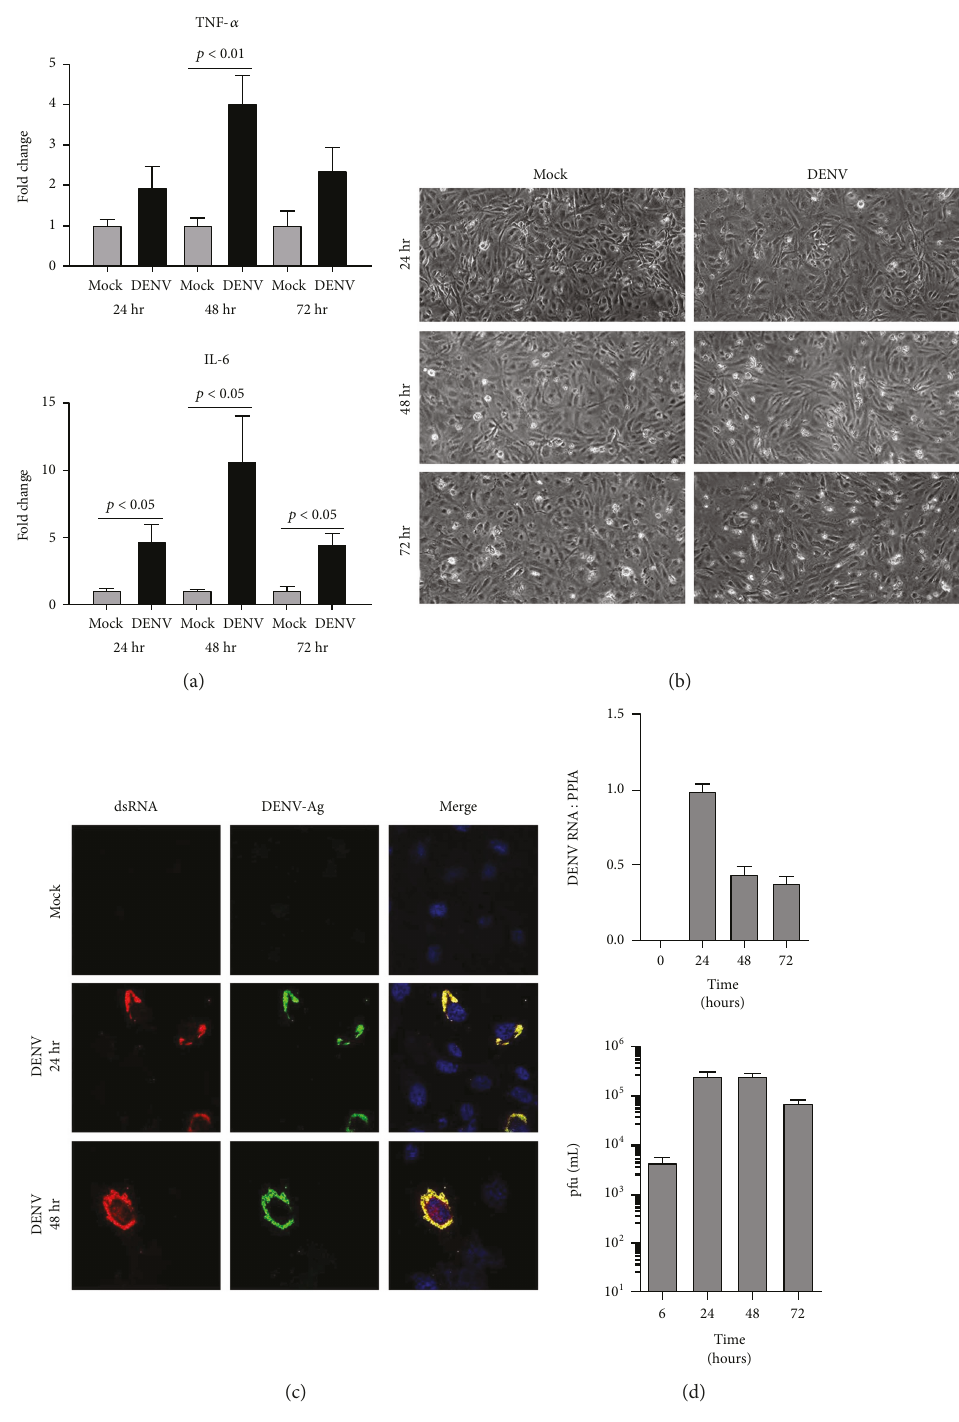
(c) Figure 2: Infection of human retinal endothelial cells with DENV: viral strain=Mon601; multiplicity of infection=1; evaluated time points postinoculation =6, 24, 48, and 72 hours (hr). (a) Graphs showing relative expression of tumor necrosis factor- α (TNF- α ) and interleukin-6 (IL-6) transcripts in DENV-infected endothelial cells versus mock-infected cells. Reference genes were glyceraldehyde-3-phosphate dehydrogenase and TATA-binding protein. Bars represent mean relative expression, with error bars showing standard deviation. n = 3 cultures/condition. Data were analyzed by two-tailed Student ’ s t -test. (b) DENV-infected and mock-infected endothelial cells viewed by light microscopy. Original magni fi cation =100x. (c) DENV- and mock-infected endothelial cells immunolabeled to detect double-stranded RNA (dsRNA) and DENV antigen (Ag). Alexa Fluor 555 (red) and Alexa Fluor 488 (green) and with Hoechst 33342 nuclear counterstain (blue). Original magni fi cation: 630x. (d) Graphs of copy number of DENV RNA for DENV-infected endothelial monolayers and plaque-forming units (pfu) for culture supernatant collected from infected cells. n = 3 cultures/condition. Bars represent DENV RNA copy number (relative to cellular peptidylprolyl isomerase A (PPIA)) or mean pfu/mL, with error bars showing standard